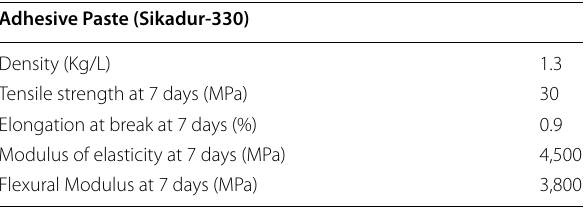
Table 3 Mechanical properties of the epoxy Sikadur‑330 Adhesive Paste (Sikadur‑330)